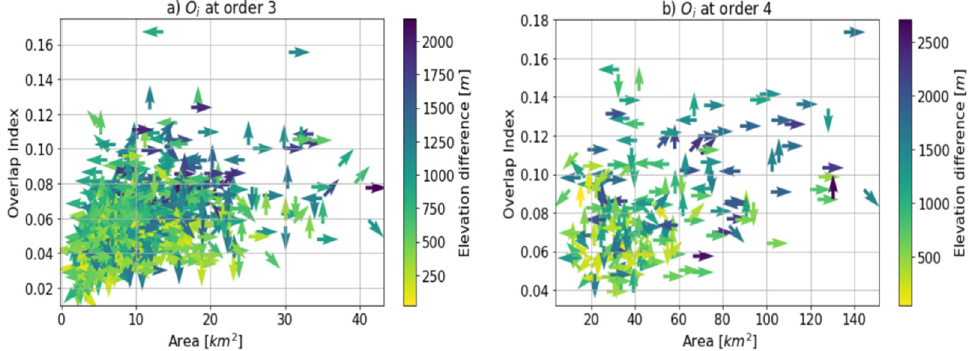
Figure 13. Overlap index for boundary sub-watersheds of orders 3 ( a ) and 4 ( b ). The arrows represent the aspect and colors the elevation difference.